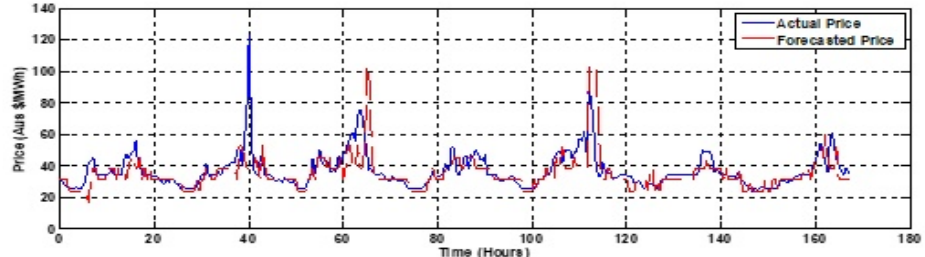
Figure 14. February 8–14, 2016 forecasting, with the maximum number of features selected in summer (MAPE = 13.70).